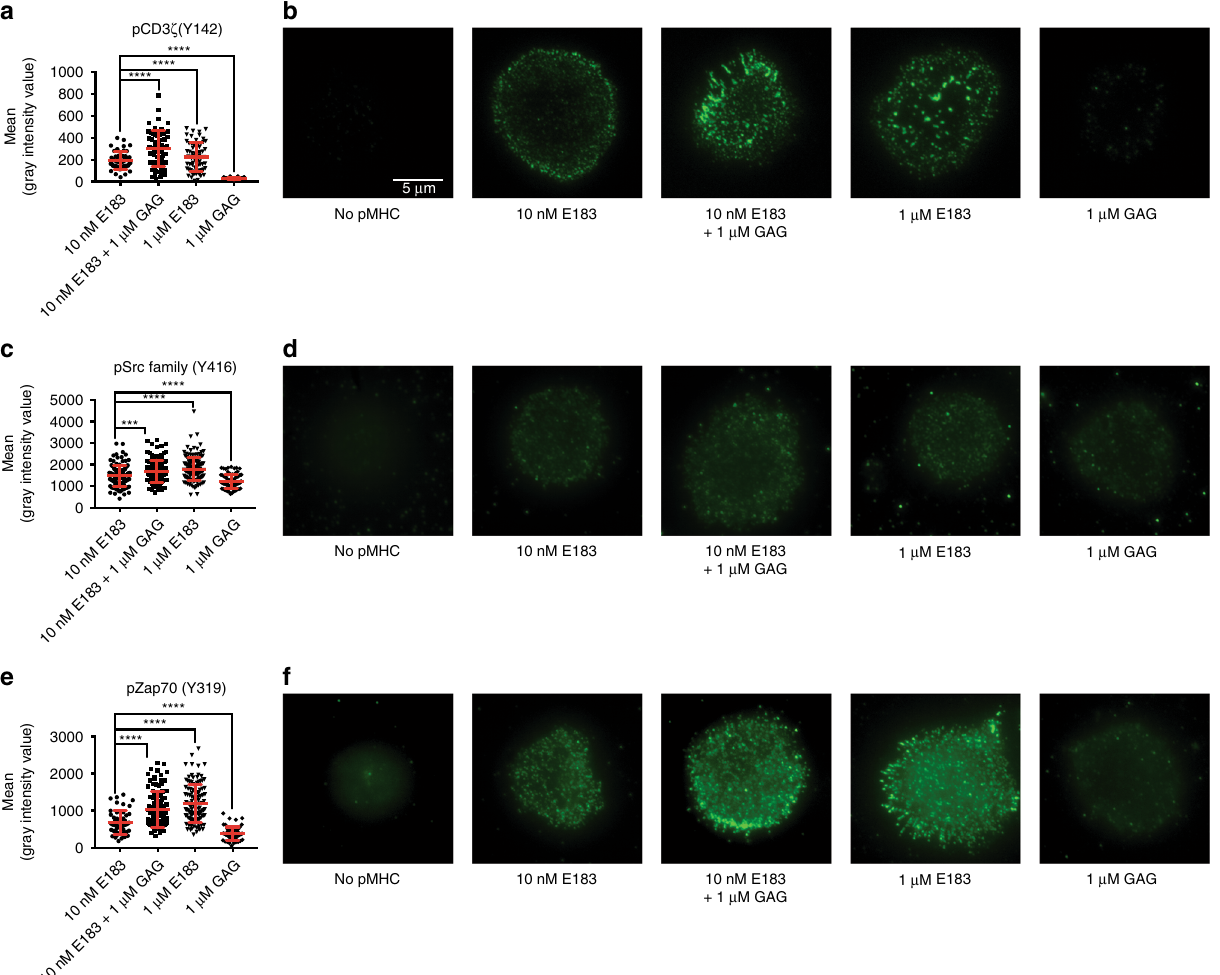
Fig. 8 Coagonist pMHC enhance the recruitment of pCD3 ζ , pLck, and pZap70 into the immunological synapse. Different concentrations of E183-A2 monomer or GAG-A2 monomer were added to the lipid bilayers in a glass chamber slide. Totally, 10 5 E183 CTL were added into each well of the chamber and stimulated for 5 min. The CTL were fi xed, permeabilized and stained with different antibodies to check the recruitment of pCD3 ζ ( a , b ), pLck ( c , d ), and pZap70 ( e , f ) into the immunological synapse by TIRF microscopy. Anti-pSrc (Y416) antibody was used to detect active Lck (p-Y394). Statistical signi fi cance was determined by using unpaired two-sided Student ’ s t test and shown as mean ± s.d. (ns nonsigni fi cant, * p < 0.05, ** p < 0.01, *** p < 0.001, **** p < 0.0001). Data are representative of three independent